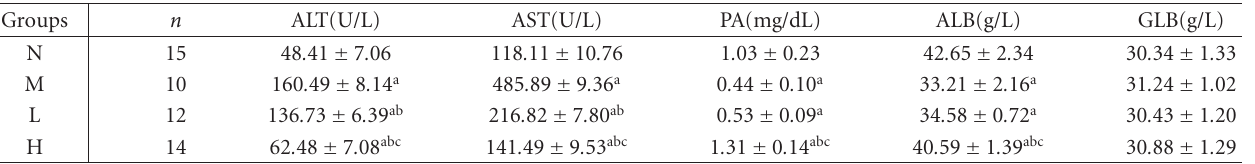
Table 1: Analysis of serum liver function indexes. Data are presented as mean ± standard error of the mean. N represented the normal control group; M represented the model group; L represented the group treated with low dose of thalidomide; H represented the group treated with high dose of thalidomide.